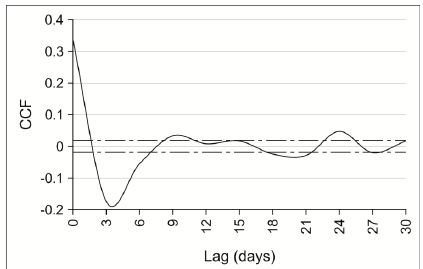
Figure 10. Residual Cross-Correlation Function: rainfall–hydrometric level. The dash-dotted lines indicate the significant thresholds .